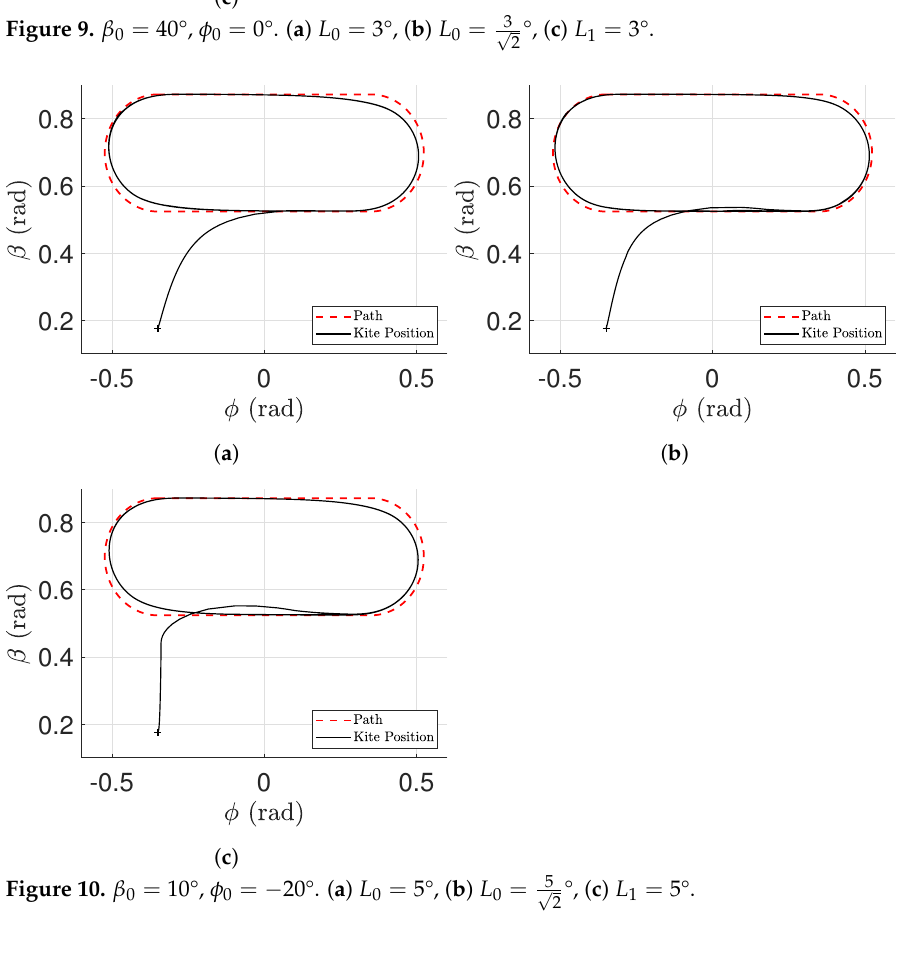
Figure 9. β 0 = 40°, φ 0 = 0°. ( a ) L 0 = 3°, ( b ) L 0 = 3 √